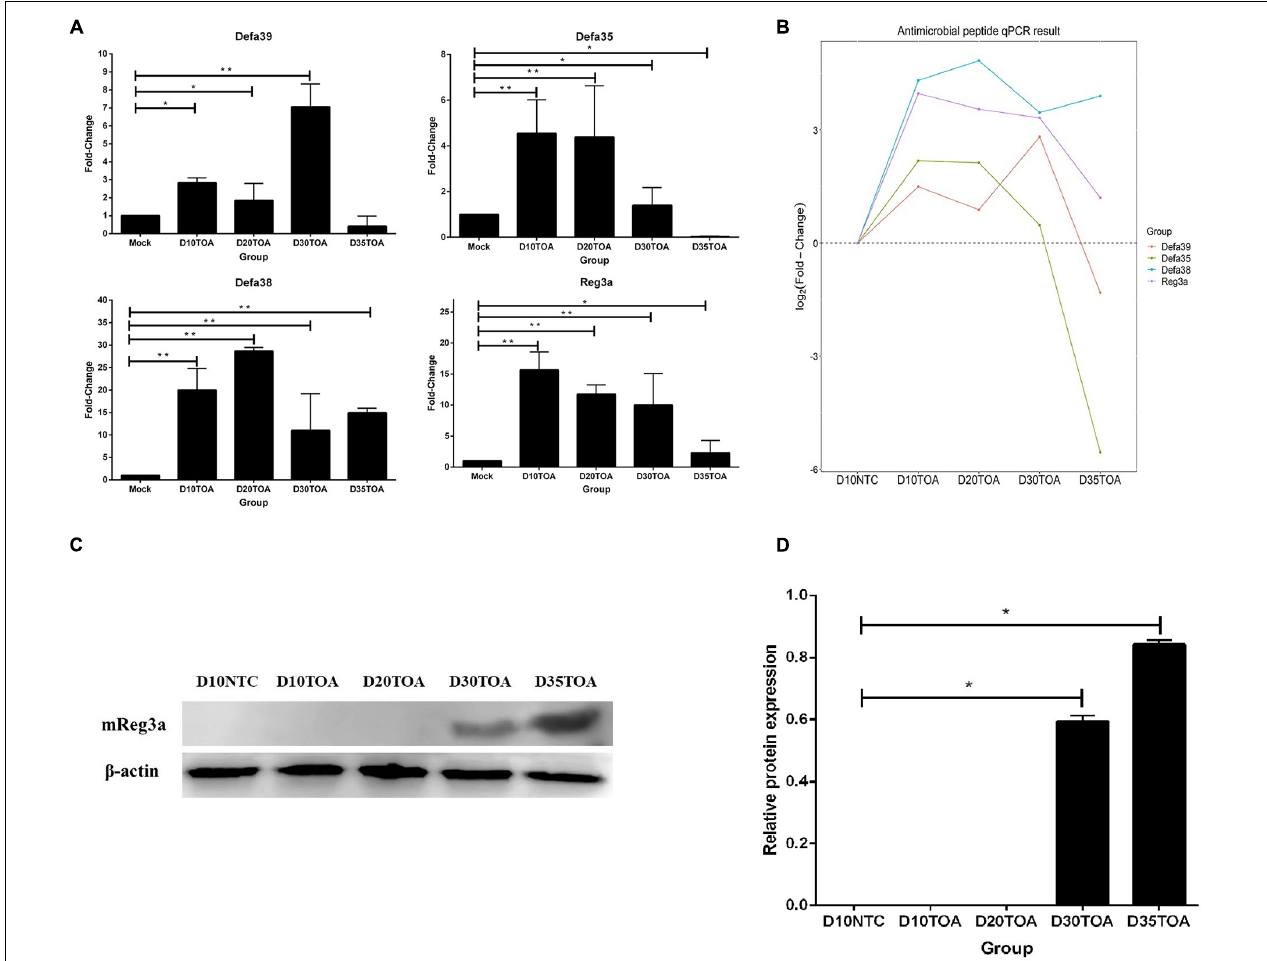
FIGURE 5 | Relative quantification of DEGs for verification by qRT-PCR. The relative quantification of Defa35, Defa38, Defa39, and Reg3a by qRT-PCR was calculated by 2 - (cid:77)(cid:77) Ct method (A) . The relative quantification data was used to show the time trend analysis (B) . Western blot data (C) were performed with bar plot by gray analysis (D) . Error bars indicate standard deviations. * p < 0.05, ** p < 0.01, and *** p < 0.001 using Student’s t -test to evaluate differences between every two